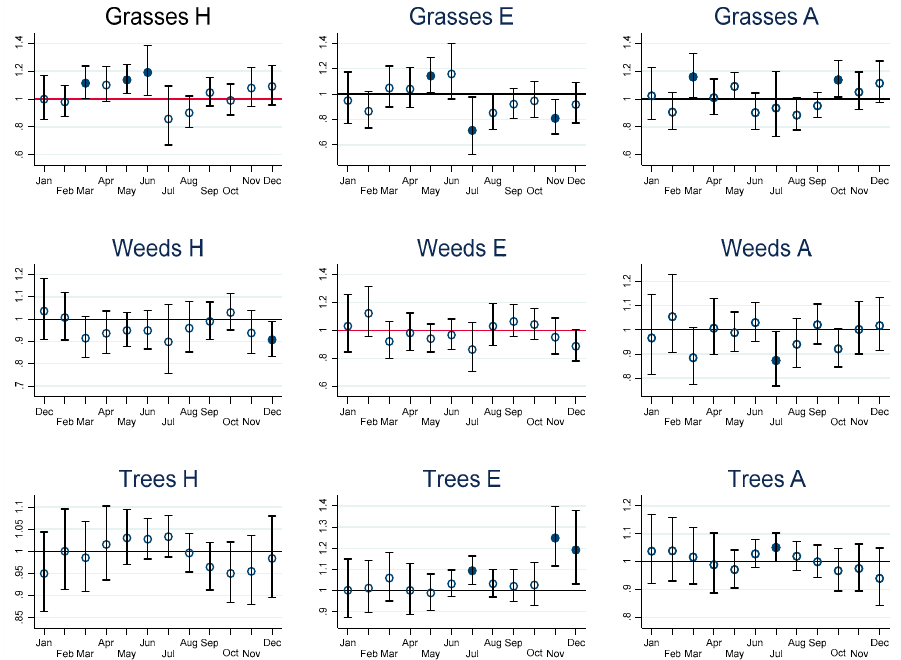
Figure 2. Short-term incidence rate ratios (IRRs) in adults for cardiovascular health outcomes. H = hospitalisation, E = emergency presentations, A = ambulance callouts. IRRs significantly different from 1 are highlighted using solid dots. IRRs refer to hospital admissions (H), emergency department presentations (E) and ambulance callouts (A) and pollen (Grasses, Weeds, Trees) by month. The estimated IRRs and associated 95% confidence intervals (95% CI) are based on an increase in 10 grains per cubic metre (10 grains per m 3 ) compared to zero grains per m 3 . Furthermore, the IRRs are based on the sum of the coefficients of the 0–7 day lags between the exposure on day zero and the daily health outcomes from day zero to day 7.